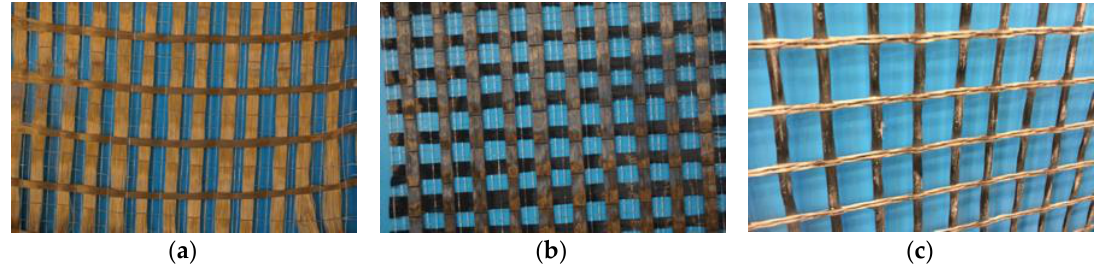
Figure 1. Types of fiber grids: ( a ) PBO grid; ( b ) carbon grid; ( c ) glass grid.